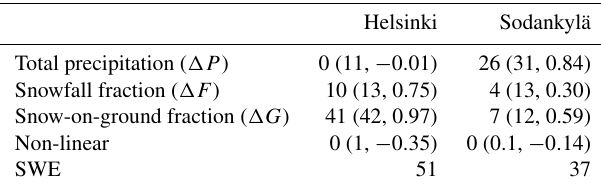
Table 2. Standard deviation (mm) of detrended March mean SWE anomalies in the years 1982–2020 decomposed into its contributions from the four rhs terms in Eq. (2). The values in parentheses give the standard deviations of the individual terms (SD ((cid:49) SWE i ) in Eq. 5) and their correlation with the SWE anomaly ( r ((cid:49) SWE i , SWE ) in Eq.